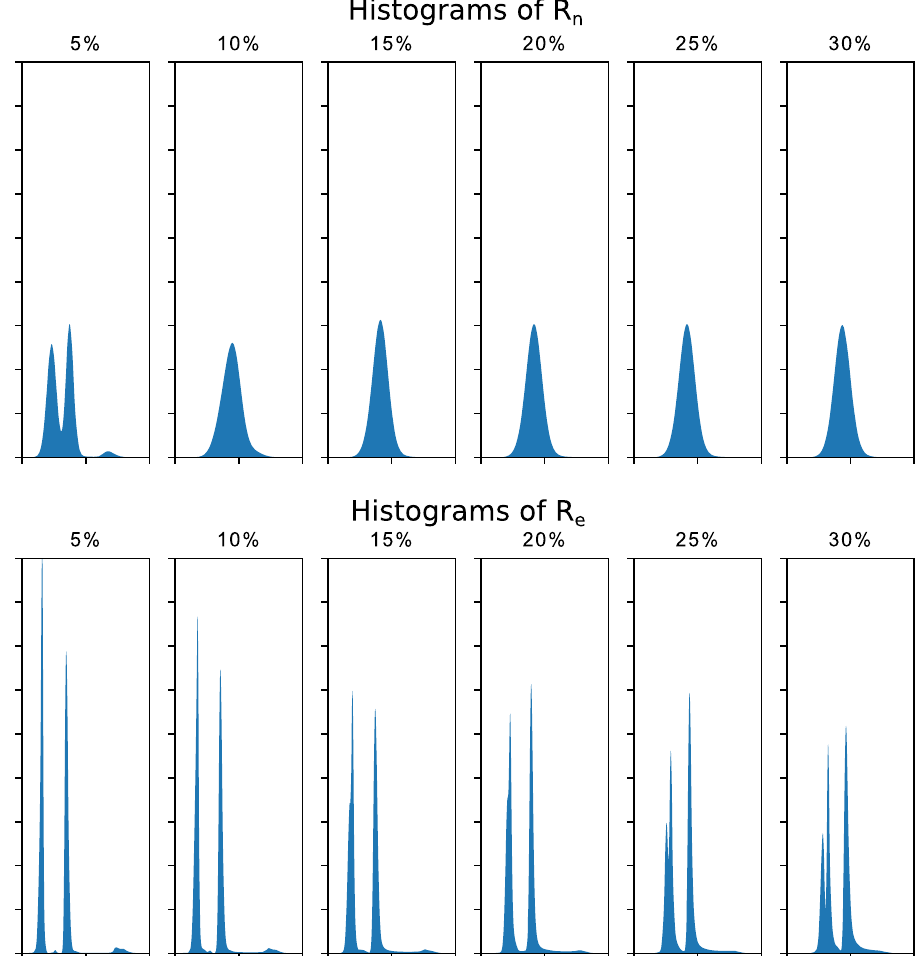
Figure 3. The histograms of the full 3D (512 slices) reconstructed datasets ( R n and R e ) obtained from the noisy ( P n ) and from the CNN enhanced projections ( P e